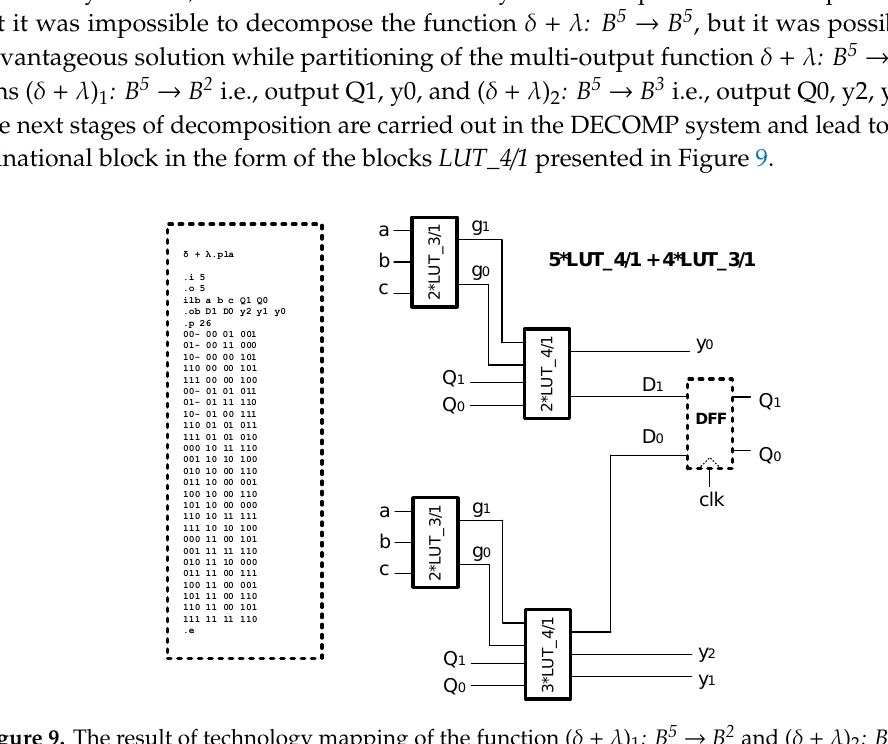
Figure 9. The result of technology mapping of the function ( δ + λ ) 1 : B 5 → B 2 and ( δ + λ ) 2 : B 5 → B 3 .